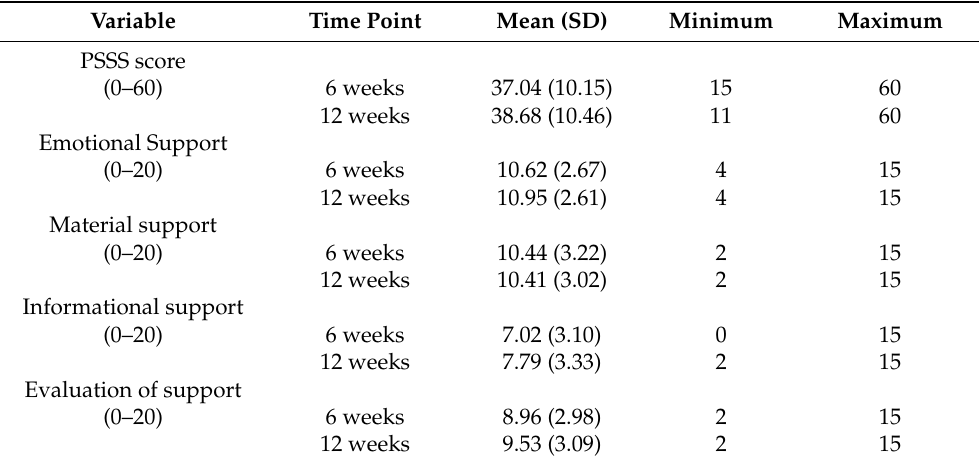
Table 7. The mean scores of PSSS and its four dimensions at 6 ( n = 544) and 12 weeks postpartum ( n = 435).